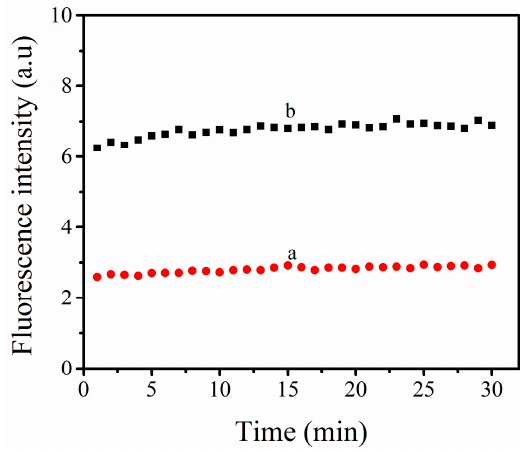
Figure 1. ( A ) Fluorescence emission spectra of different concentrations of TPE-2N+ in Tris-HCL buffer. From bottom to top: 0, 5, 10, 20, 50, 100 μ M. ( B ) The linear relationship between the fluorescence intensity and the concentration of TPE-2N+ in Tris-HCL buffer.